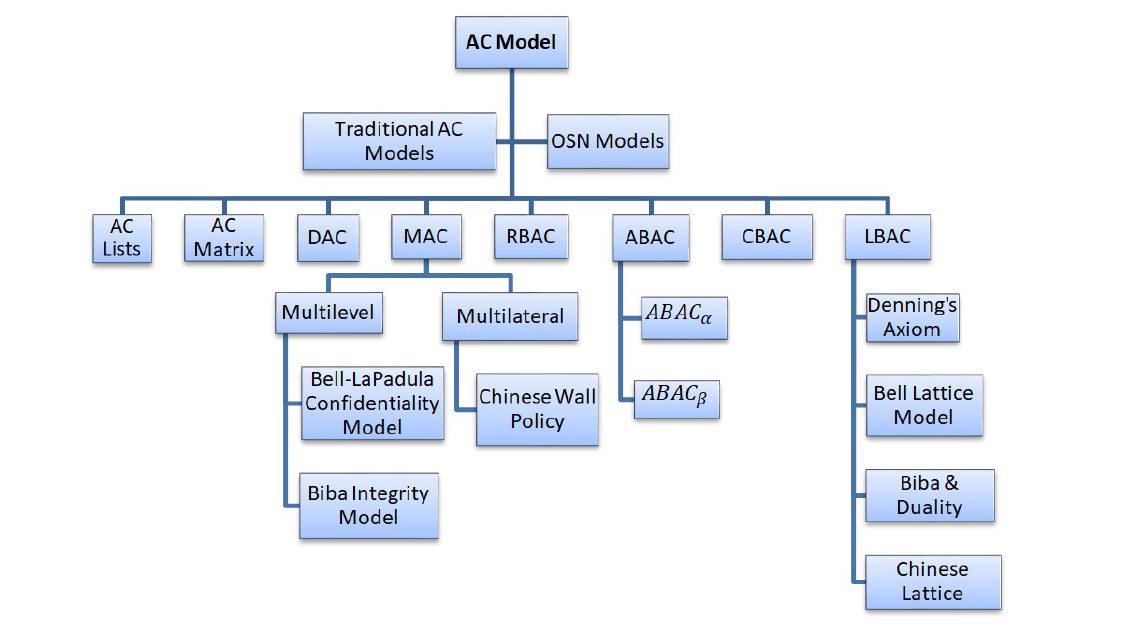
Figure 2. Taxonomy of AC Models in Conventional Systems.